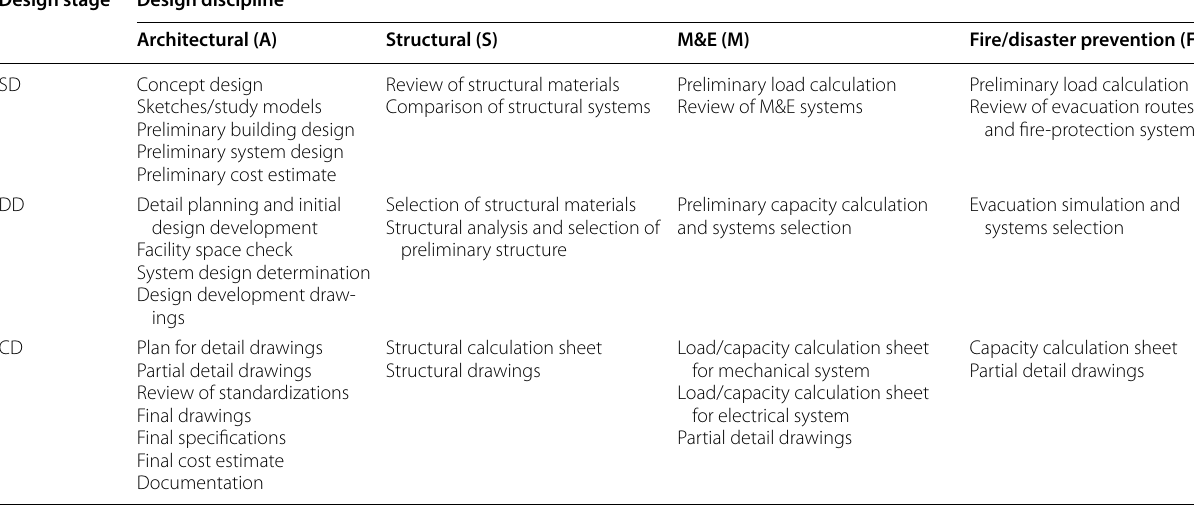
Table 3 Design activities at each design